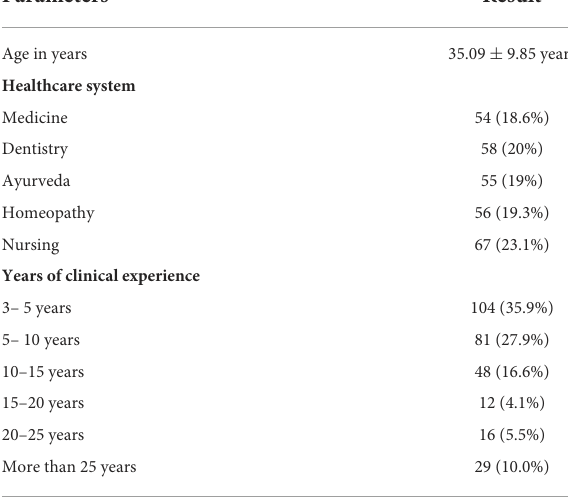
TABLE 1 Characteristics of the study population.